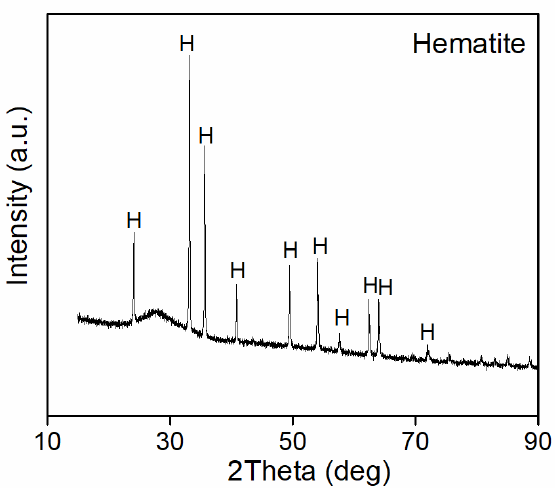
Figure A12. XRD result from the model grisaille. Hematite (H), tenorite (T), and cuprite (C) were identified.